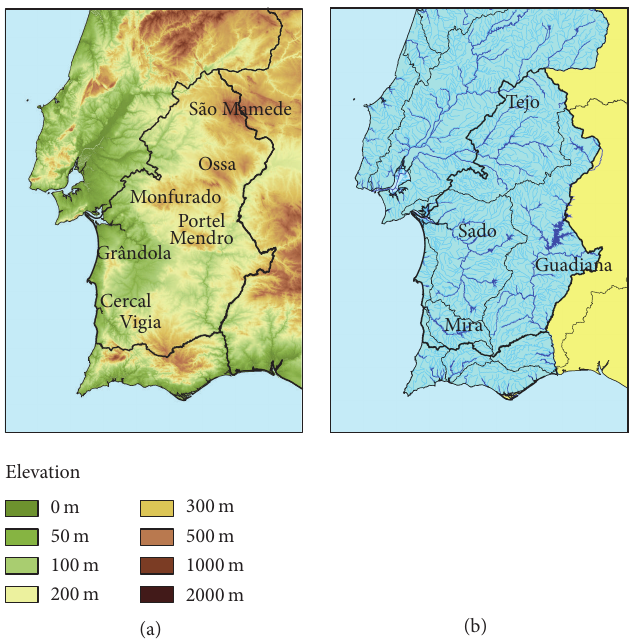
Figure 1: (a) Regional orography and main elevations; (b) main hydrographic